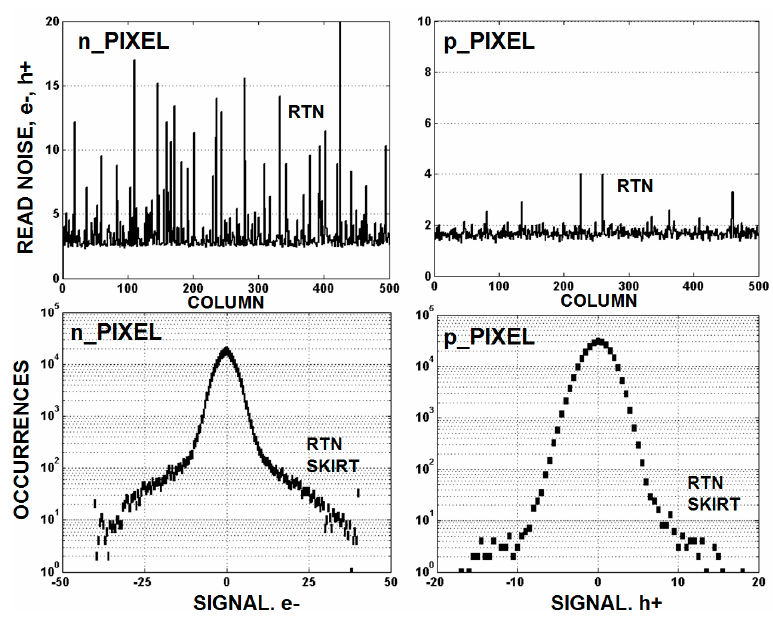
Figure 7. Random telegraph noise (RTN) population comparison for NMOS (n_pixel) and PMOS (p_pixel) pixels.